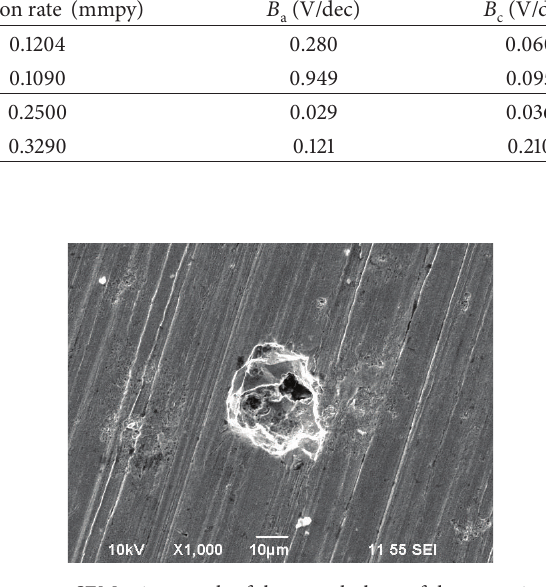
Figure 7: SEM micrograph of the morphology of the corrosion for Sg. Ular SRB strain after 30